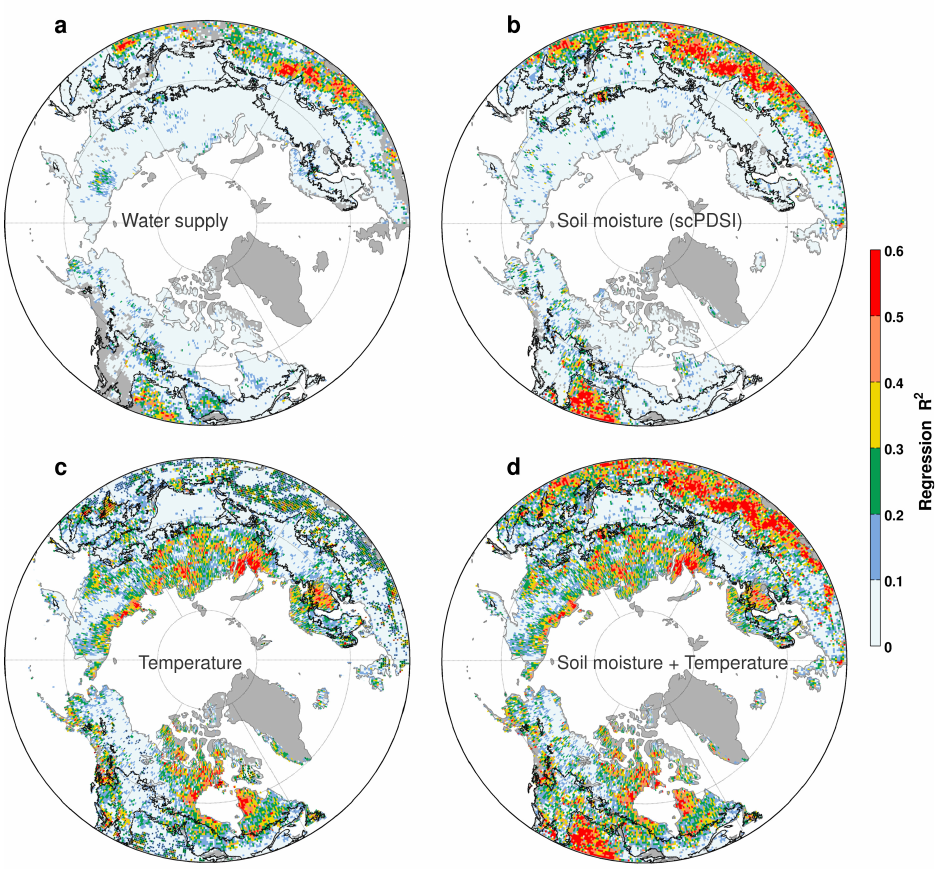
Figure 6. Fraction of interannual summer NDVI variance explained by spring (March-May) and summer water supply, soil moisture and temperature during the period 1982–2009. The maps show the R 2 for a stepwise multiple linear regression model predicting summer NDVI at each grid box based on: ( a ) water supply ( x = peak SWE, x = summer precipitation); 1 2 ( b ) soil moisture ( x = spring scPDSI, x = summer scPDSI); ( c ) temperature ( x = spring 1 2 1 temperature, x = summer temperature); and ( d ) soil moisture and temperature ( x = spring 2 1 scPDSI, x = summer scPDSI, x = spring temperature, x = summer temperature). All the 2 3 4 variables were linearly detrended prior to analysis and only predictors significant at the 90% confidence level were retained in the regression models. Only positive associations between summer NDVI and variables representing water supply and soil moisture were considered. The stippling in c indicates grid boxes where NDVI is inversely associated with temperature. Gray shading denotes non-vegetated areas or areas where climate data were not